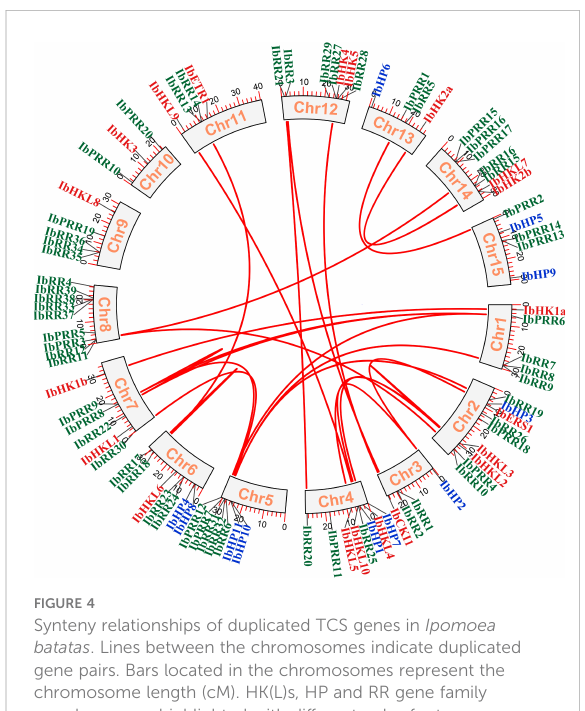
con fi rmed that the expansion of TCS genes in I. batatas was mainly attributed to both segmental and tandem duplications. In contrast, the expansion of HK(L)s and HPs mainly depended on segmental duplications, whereas the expansion of type-C RRs mainly depended on tandem duplications.